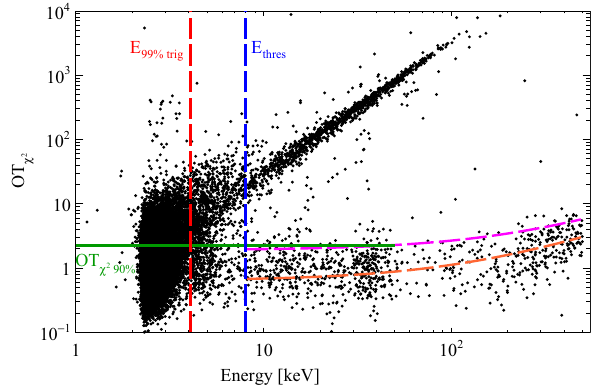
Fig. 2 A typical distribution of OT χ 2 as a function of energy for one BoDs. Physical events due to the particle interactions in the TeO 2 crys- tals are distributed in a nearly-horizontal band around OT χ 2 ∼ 1. Non- physical events such as electronic noise and tower vibrations, as well as particle interactions in the thermistors, follow an oblique distribu- tion. The green solid line corresponds to the 90th percentile of the OT χ 2 distribution ( OT χ 2 90% ) calculated in the region [35–50 ] keV and OT χ 2 < 10 using physics data. The magenta (orange) dashed line cor- responds to the 90th (50th) percentile calculated using calibration data in the region [100–500 ] keV and OT χ 2 < 10, assuming linear depen- denceonenergy.Redandbluedashedverticallinesrepresentthetrigger threshold E 99%trig and the analysis threshold E thres ,